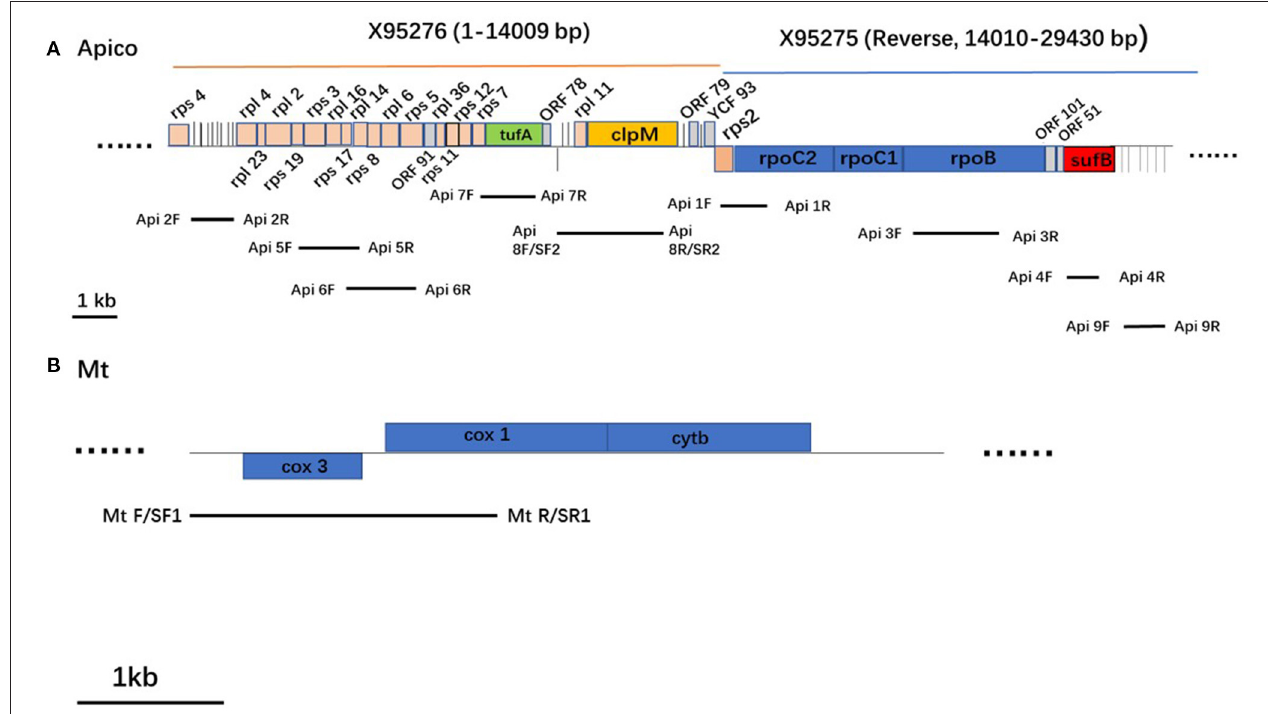
FIGURE 2 | Schematic representation of the apicoplast genome (A) and mitochondrion genome (B) in Plasmodium falciparum . Protein coding genes are boxed and color-coded. tRNAs are represented by vertical lines. Genes shown above the horizontal line in each genome are transcribed left to right, and those below are transcribed from right to